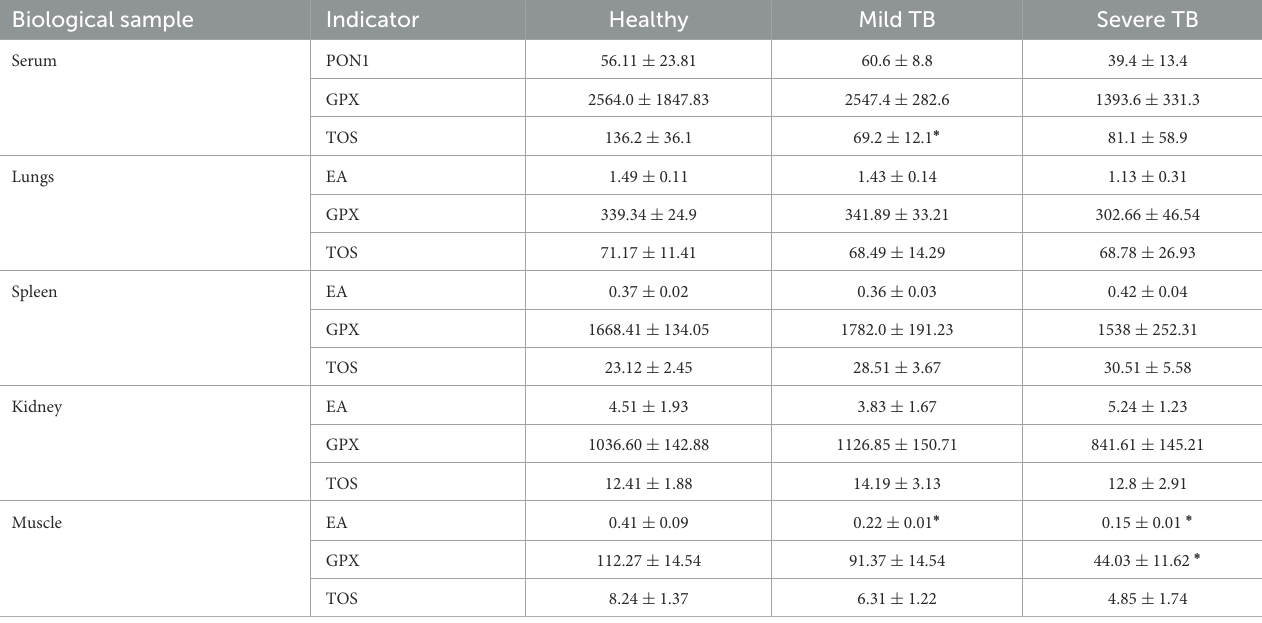
TABLE 2 Mean ± standard deviation for PON1 (paraoxonase 1), EA (p-nitrophenyl esterase activity), GPX (glutathione peroxidase), and TOS (total oxidative serum) measured in serum, lung, spleen, kidney, and muscle from healthy and TB-infected (mild and severely affected) wild boar, hunter-harvested in central